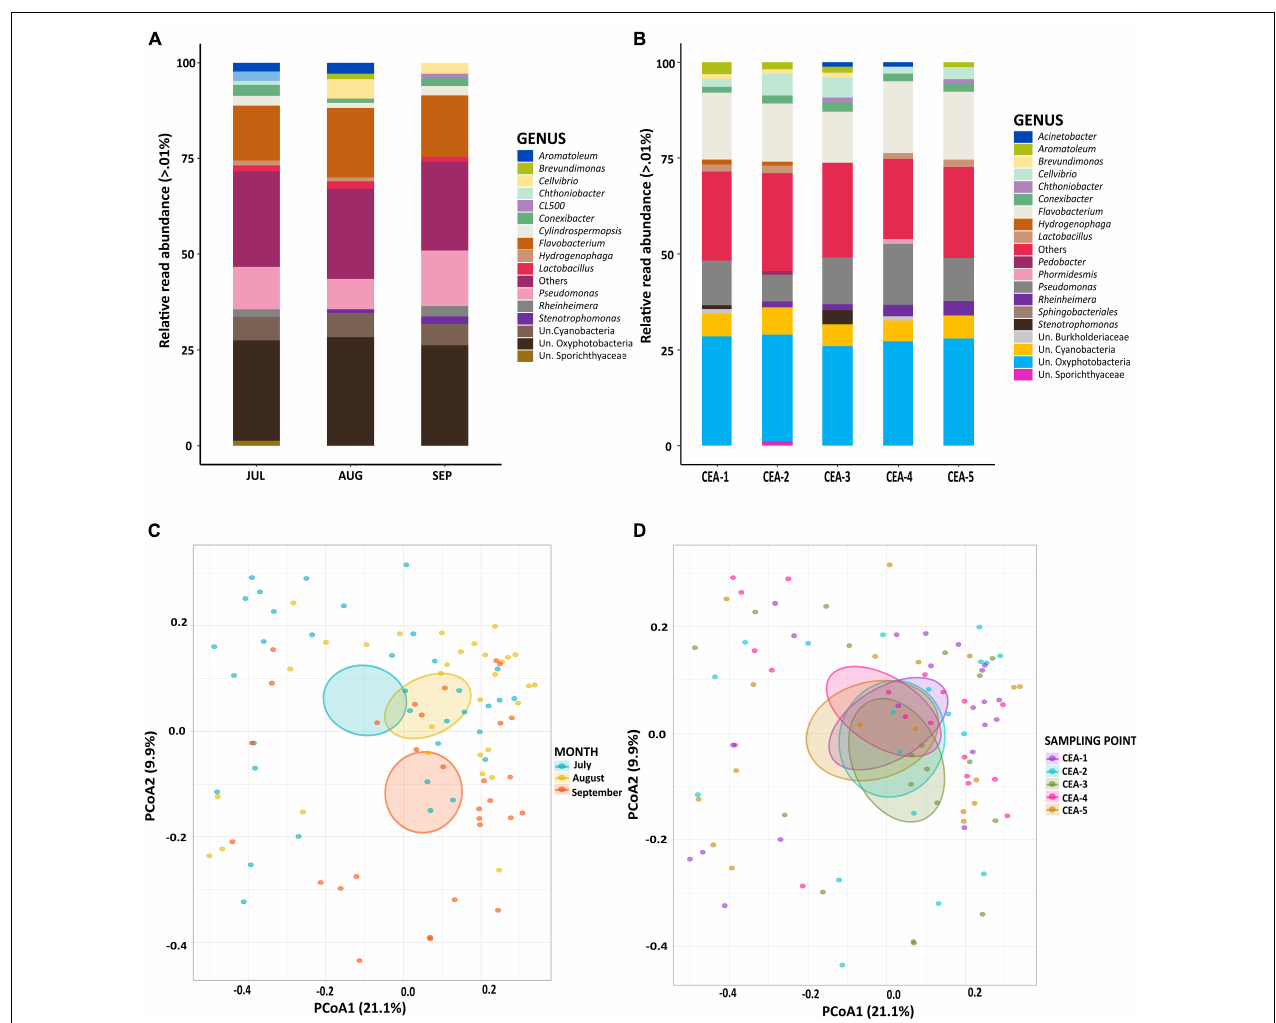
FIGURE 2 | (A) Relative read abundance levels of bacterial genera by sampling month. (B) Relative read abundance levels of bacterial genera by sampling site. (C) PCoA of the bacterial communities to compare sampling months. (D) PCoA of the bacterial communities to compare sampling sites. Un.: